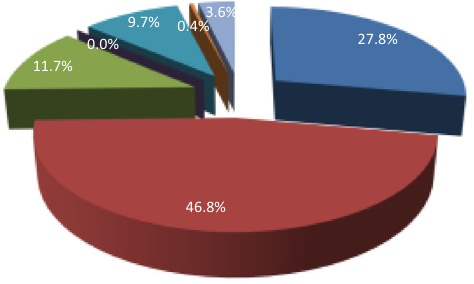
Fig. 1 Transport mode in home-school